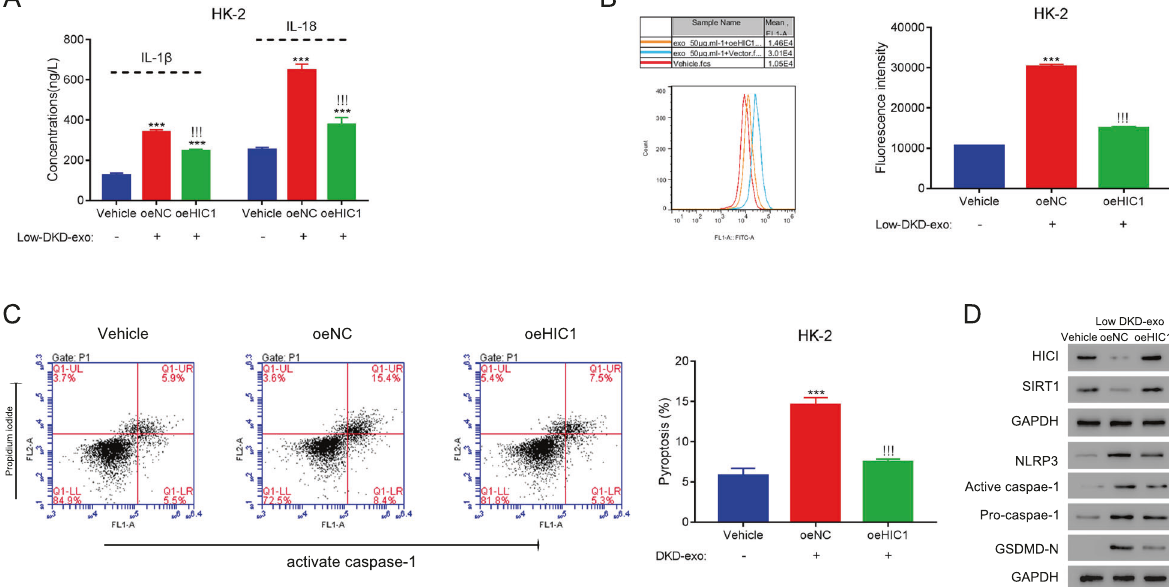
Fig. 6 HIC1 suppresses ROS levels and pyroptosis caused by DKD exosomes in kidney cells. HK-2 cells transfected with vehicle, empty vectors (oeNC), or HIC1 plasmids (oeHIC1) were treated with exosomes isolated from low-DKD patients for 24 h. A The secretions of IL-1 β and IL-18 were quanti fi ed using ELISA. B ROS levels were quanti fi ed using the DCFDA assay kit. C Pyroptosis was measured by quantifying cells with active caspase-1. D Expression of indicated proteins was measured by western blotting. *** P < 0.001 vs. vehicle, !!! P < 0.001 vs.